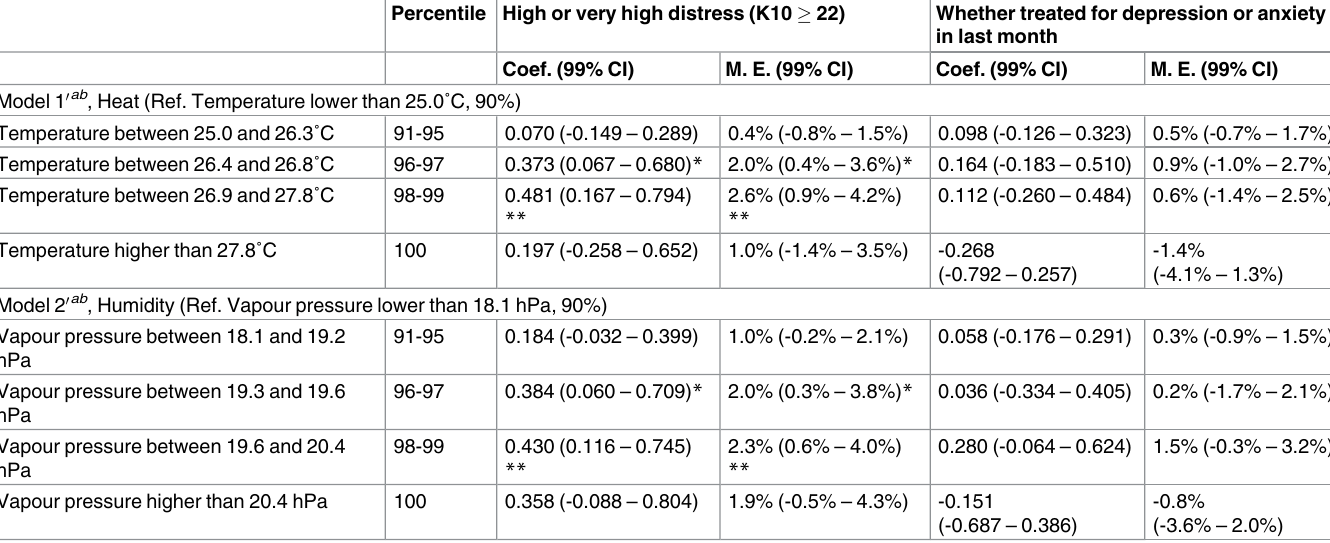
Table 3. Non-linear associations between temperature (heat), vapour pressure (humidity) and mental health, Logit model, 53,144 adults aged over 45 from NSW,